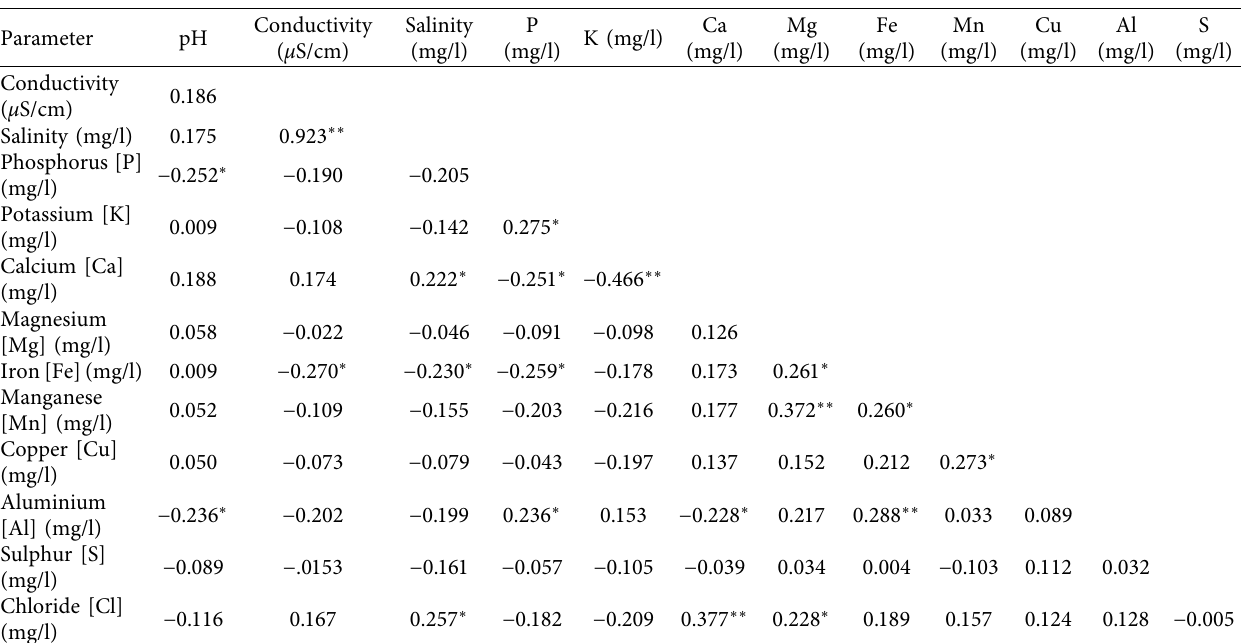
Table 1: Associations between soil chemical